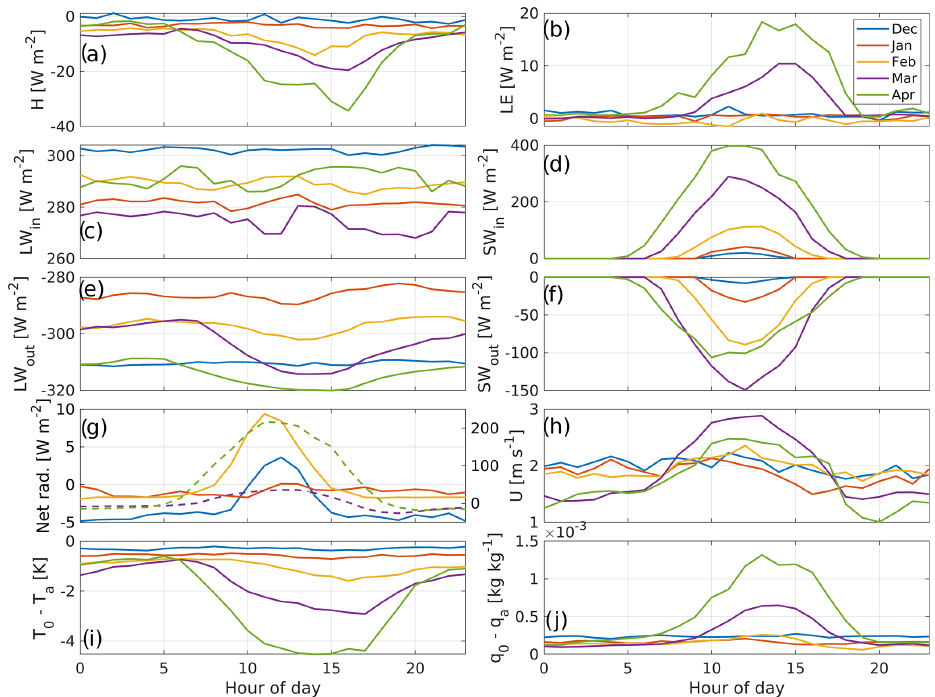
Figure 3. Hourly medians of key variables measured over the lake ice: (a) H and (b) LE measured by EC, all four components of the radiation balance separately (c–f) , (g) net radiation, (h) wind speed, (i) temperature difference ( T 0 − T a ) and (j) specific humidity difference ( q 0 − q a ). Each curve represents a month of data separated into each hour of the day. Note that the turbulent fluxes have the micrometeorological notation, where negative is flux towards the surface, while net radiation and radiation flux components have the opposite notation. The net radiation plot has two vertical axes to accommodate the higher fluxes of March and April (dashed lines, scale on the right-hand side), and solid lines represent the months from December to February (scale on the left). All times are in UTC +